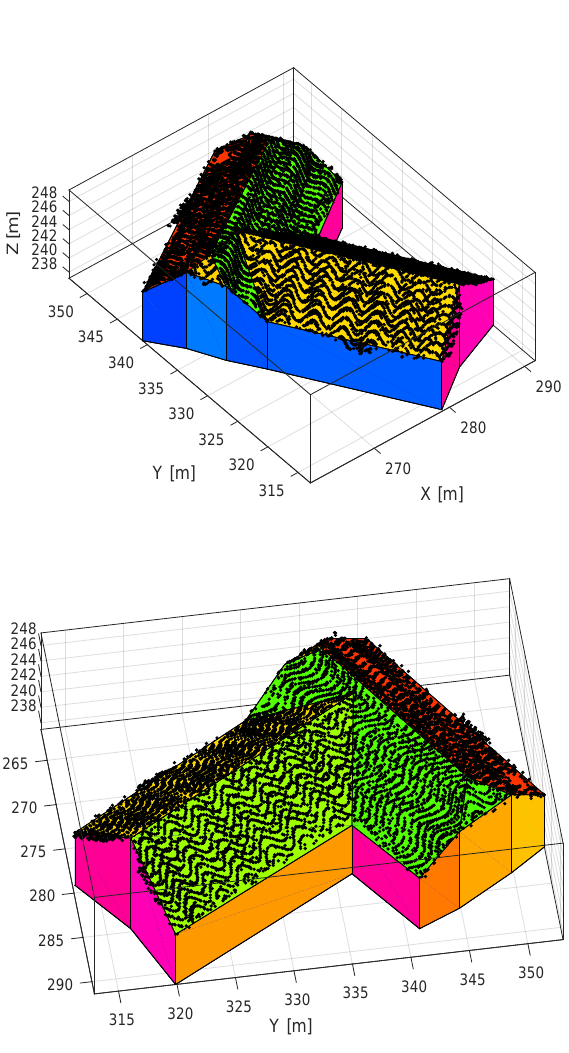
Figure 2. Points of an airborne laser scan captured by a RIEGL LMS-Q560 scanner and the deduced boundary representation in two views. The points represent the roof areas of a farmhouse. horizontal and the building’s outline is rectangular. Of course, the slopes for the roof areas is